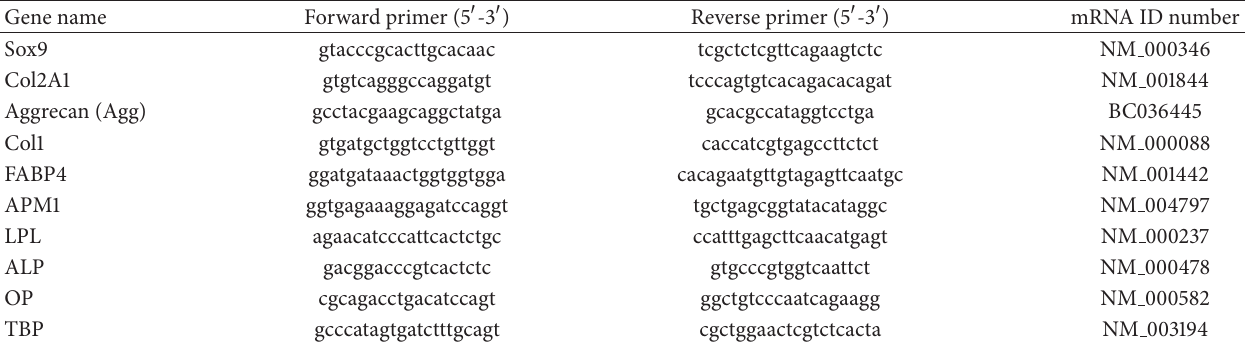
Table1:SequencesofqPCRprimersusedfortheamplificationofhumanmRNAcorrespondingtoadipogenic,osteogenic,andchondrogenic- specific